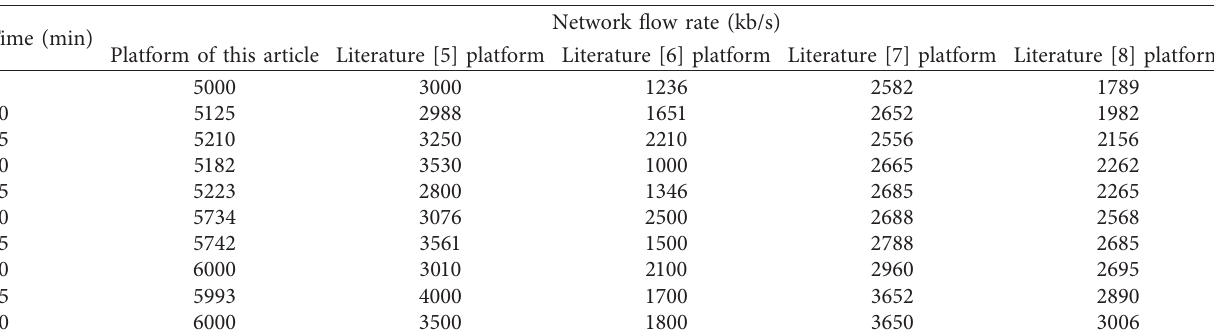
Table 4: Comparison of network flow rates of all